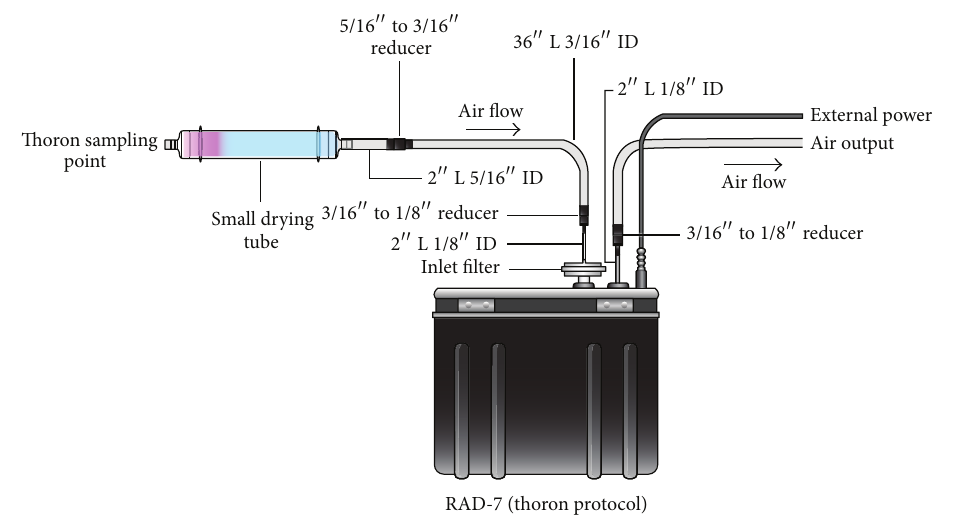
Figure 3: Experimental setup for operating the counting system for thoron